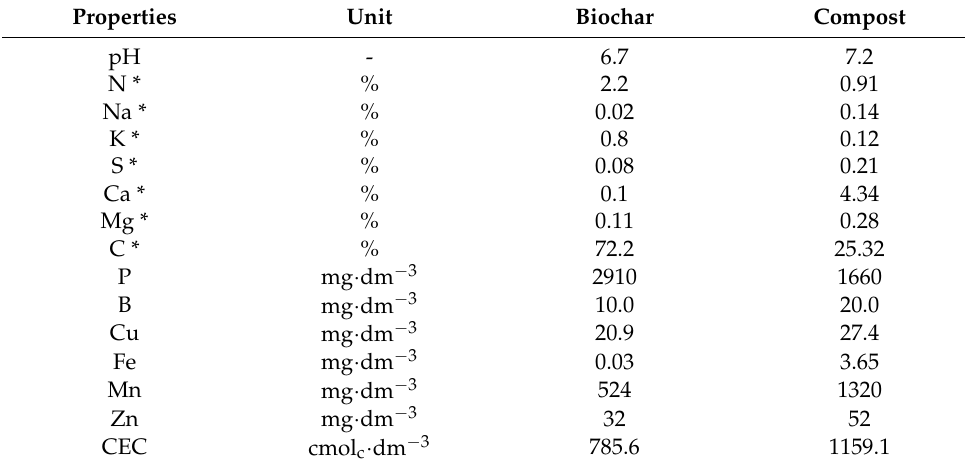
Table 1. Chemical characterization of organic compost and